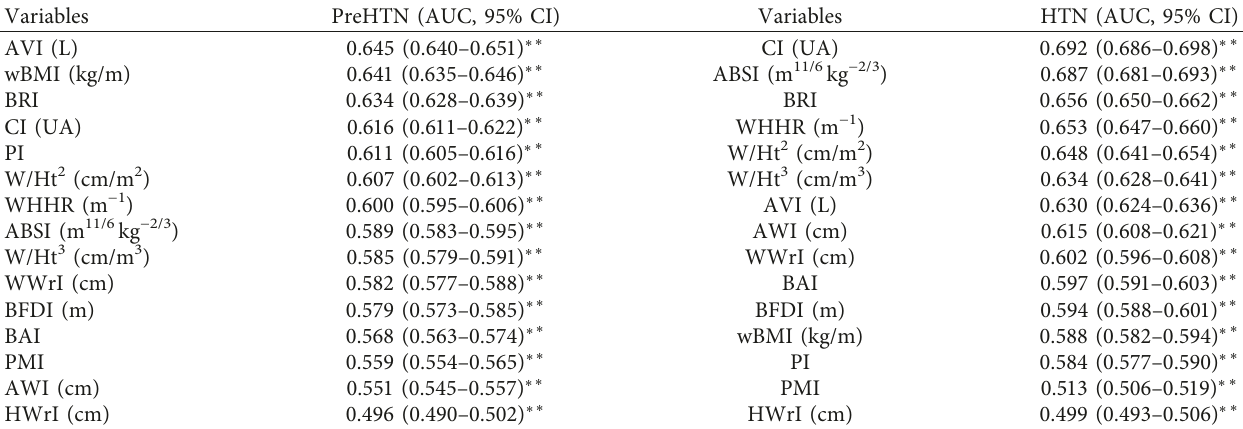
Table 2: Predictive value of the emergent anthropometric indices to preHTN and HTN in the total sample.